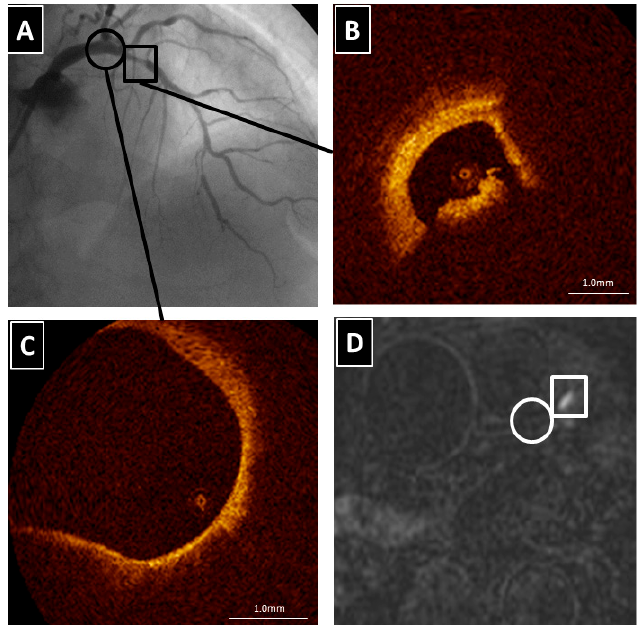
Figure 3. The culprit lesion in the proximal left anterior descending coronary artery (LAD). ( A ) Coronary angiography revealing severe coronary stenosis in the proximal LAD (square) and no significant stenosis in the left main coronary artery (LMCA) (circle); ( B ) The OCT examination showing intracoronary thrombus in the proximal LAD; ( C ) There is a lipid-rich plaque in the LMCA (circle); ( D ) Coronary T1WI demonstrating HIS in the area corresponding to the culprit lesion of the proximal LAD (square). However, no HIS in the LMCA with the lipid-rich plaque is found (circle).